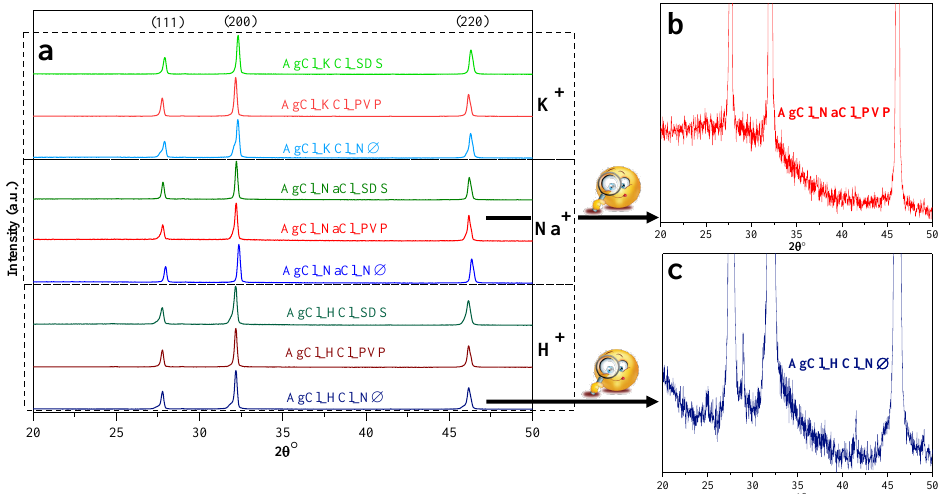
Figure 1. Structural properties of AgCl photocatalysts: ( a ) X-ray diffraction (XRD) patterns of AgCl photocatalysts prepared using different shape-tailoring agents (NØ); polyvinylpyrrolidone (PVP) and sodium dodecyl sulfate (SDS)), alkali metals (Na + , K + ) and H + ; diffraction patterns of ( b ) AgCl_NaCl_PVP and ( c )